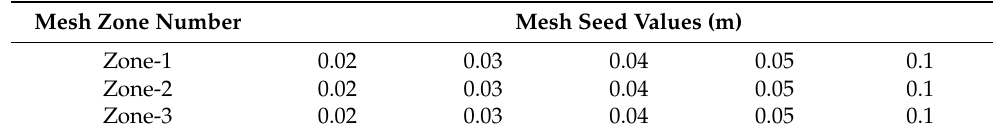
Table 7. Mesh sensitivity parameter setting.